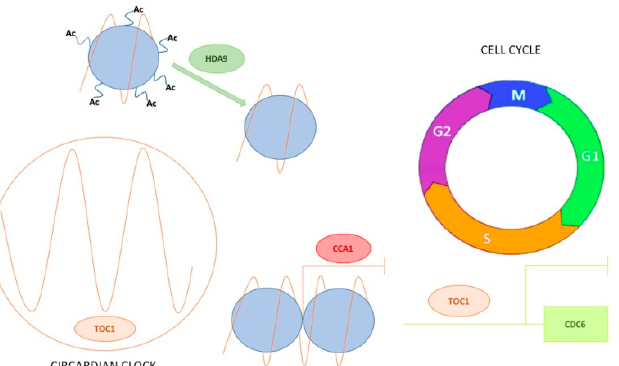
Figure 2. Epigenetic regulation of clock components and their role during cell cycle. ( Left ) Histone modifications modulate the rhythmic expression of clock genes: at dusk TIMING OF CAB EXPRESSION 1 (TOC1) expression increases due to hyperacetylation. Once TOC1 reaches its peak, the downregulation is accompanied by the action of the histone deacetylase HDA9 which facilitates CIRCADIAN CLOCK ASSOCIATED 1 (CCA1) mediated repression at the end of the day. ( Right ) At the transition between Gap 1 (G1) and duplication of DNA (S) phase, TOC1 regulates the progression of the cell cycle by repressing the expression of CELL DIVISION CONTROL 6 ( CDC6 ) responsible for DNA replication.